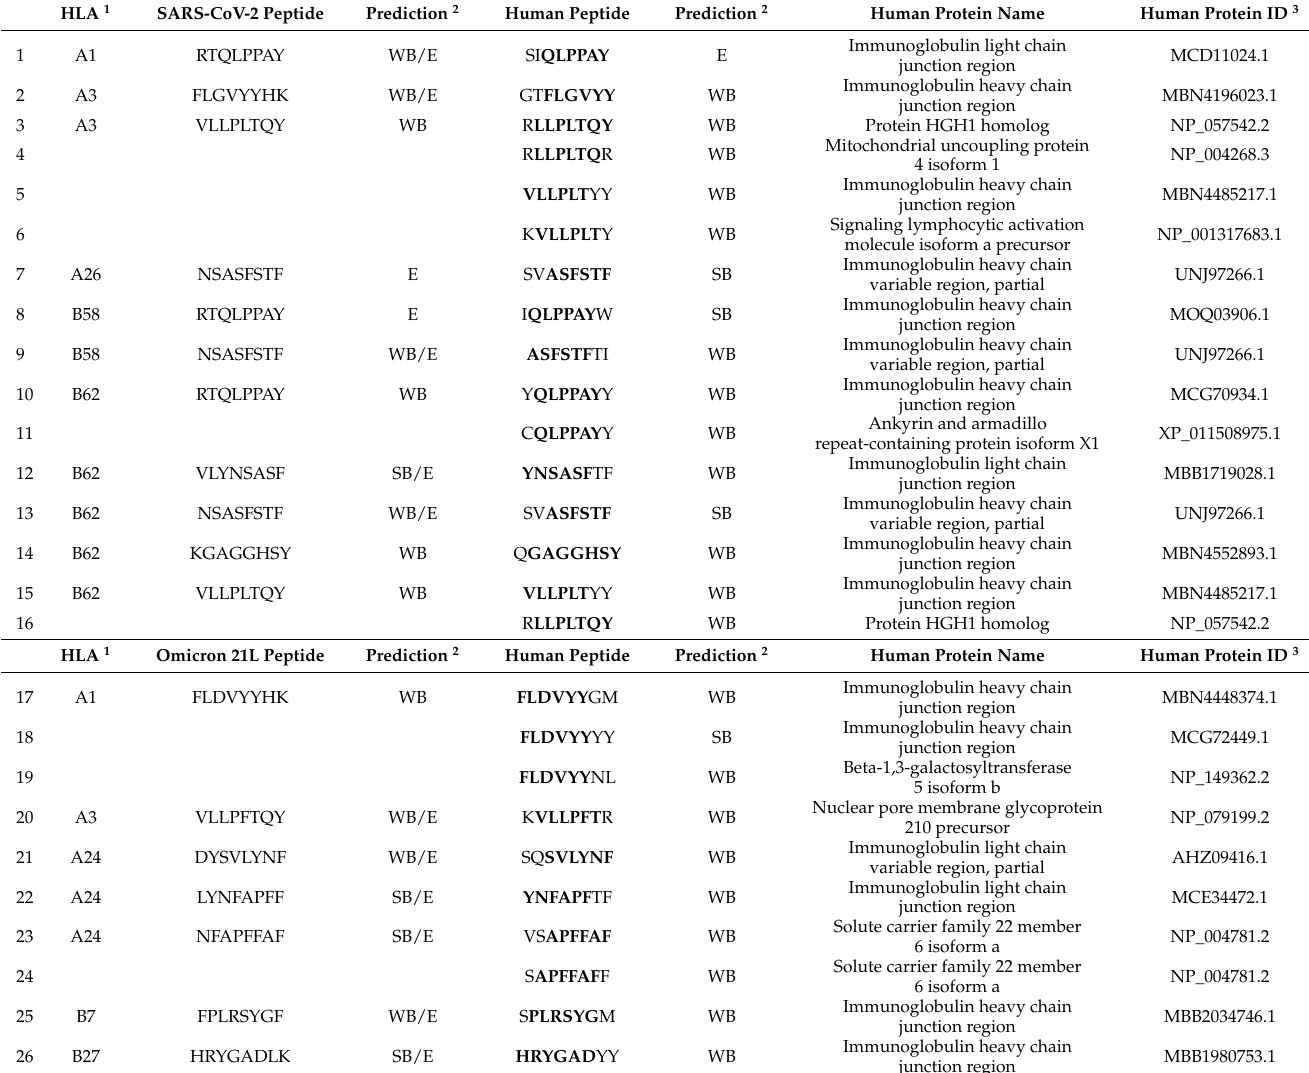
Table 3. Viral (SARS-CoV-2 and Omicron 21L) and human peptides that share 6mers at the Omicron 21L-specific mutation sites and have affinity to the same HLA. The first 16 data rows are the respective SARS-CoV-2 and human peptides. The rest are the Omicron 21L and human peptides. (Table format features are the same as the relevant explanation at the caption of Table